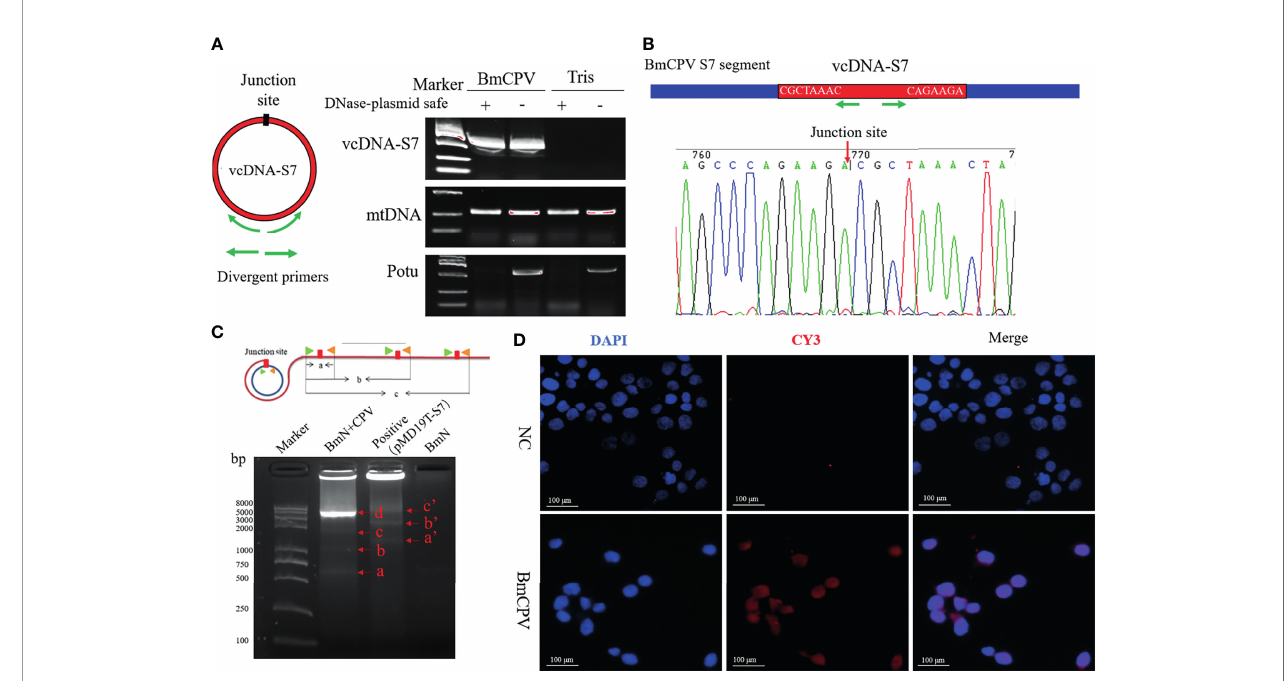
FIGURE 1 | mori produces BmCPV-derived circular DNA vcDNA-S7. (A) vcDNA-S7 was veri fi ed by divergent PCR. left, Schematic of primer to validate the junction site of vcDNA-S7. Green arrow represents divergent primers. Right, electrophoresis of PCR product from fl anking sequence of the junction site of vcDNA-S7. DNA from BmCPV infected silkworm midgut and healthy silkworm midgut were extracted. RNAs and linear DNAs were respectively removed with RNase A and